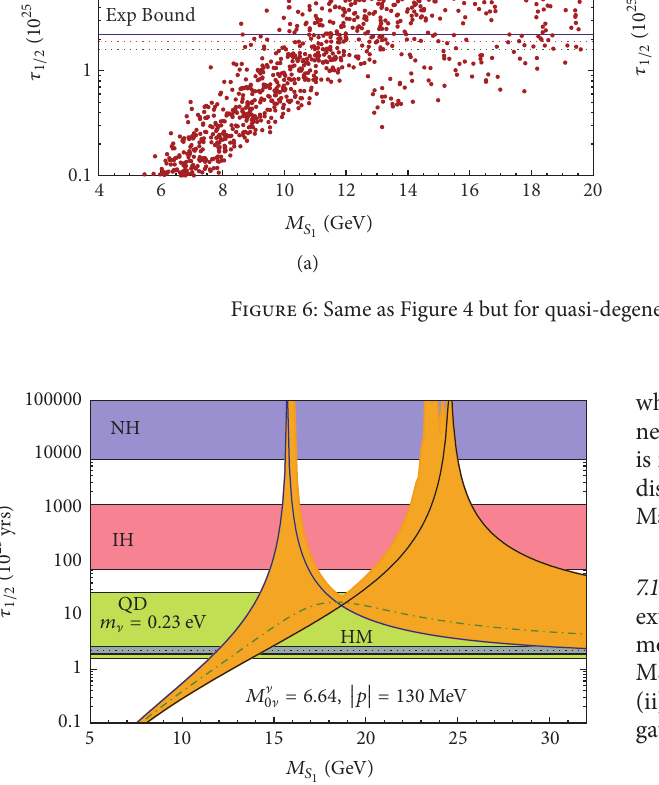
Figure 7: Prediction of half-life for double beta decay as a function of sterile neutrino mass in the case of QD type mass hierarchy with the common mass parameter 𝑚 0 = 0.23 eV. The peaks correspond to cancellation between light neutrino and sterile neutrino exchange amplitudes when Majorana CP phases of sterile neutrino are ignored. The dotted line shows the absence of peaks when CP phases are included